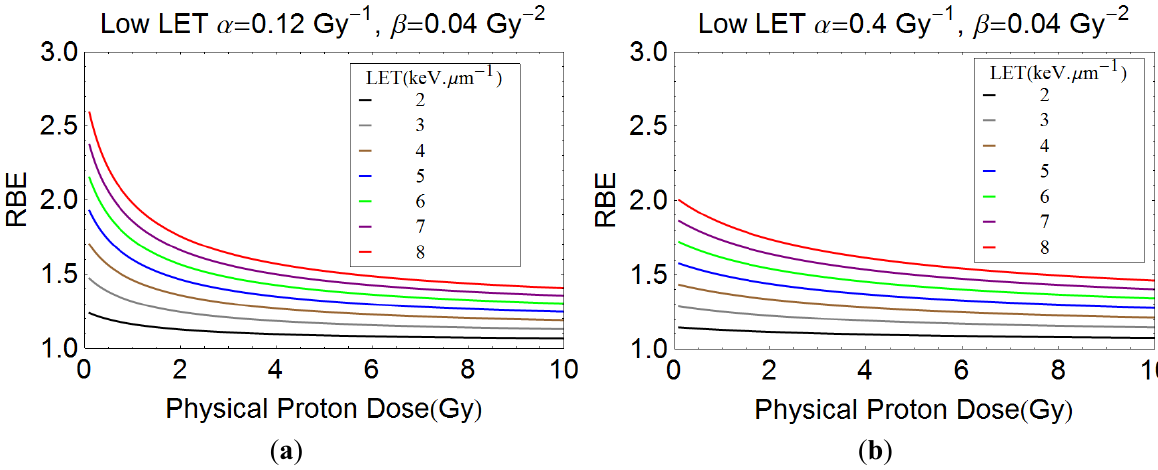
Figure 4. ( a ) and ( b ) show plots of RBE with dose per fraction for a wide range of LET values, with the assumed radiosensitivity parameters shown.